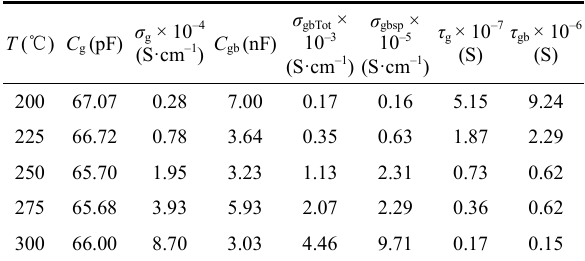
Table 5 Equivalent circuit fitted parameters of x = 0.175 at 200–300 ℃